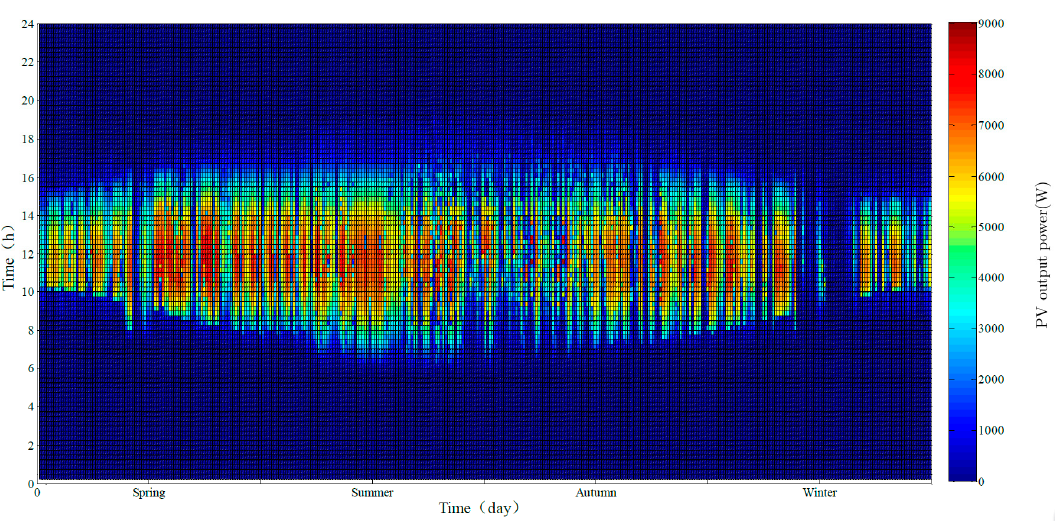
Figure 3. Time series characteristics of annual output power of 2016.